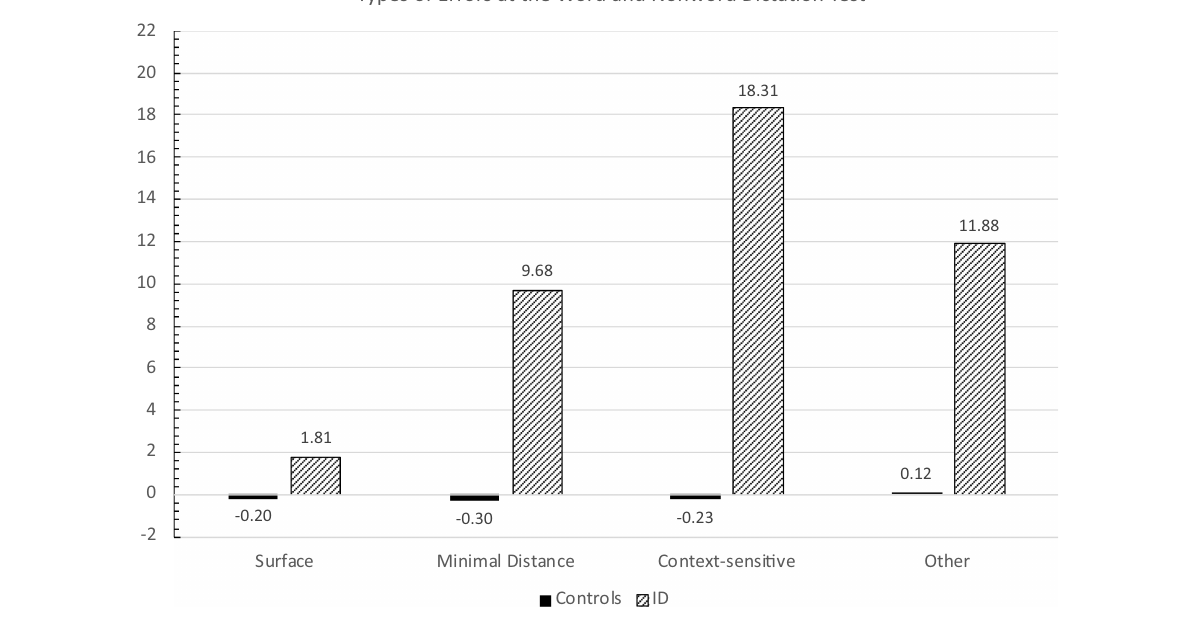
FIGURE 4 Mean errors z scores for the various categories of errors in the Words and Nonwords Dictation Test committed by control and ID